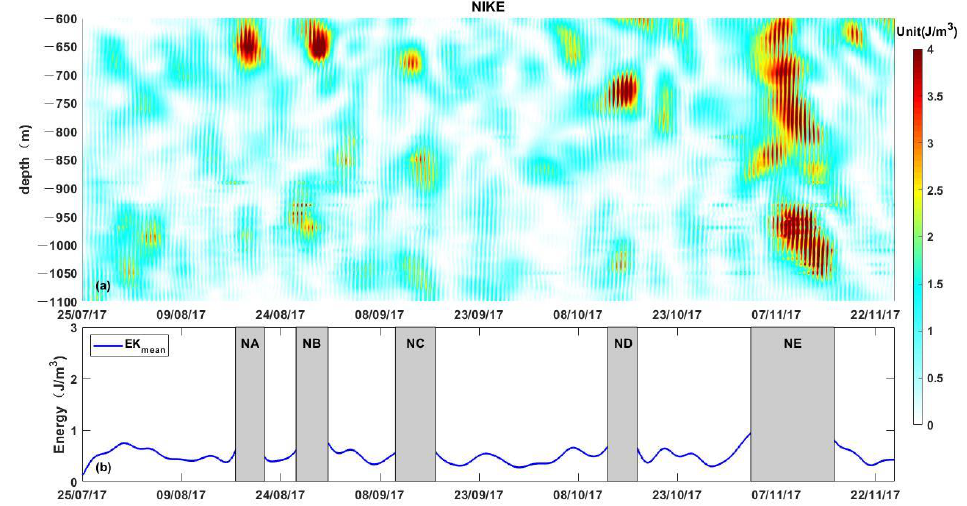
Figure 3. ( a ) Depth–time map of near-inertial kinetic energy (NIKE) per unit of volume, NIKE = 0.5 ρ ( u f 2 + v f 2 ) (J/m 3 ), and ( b ) depth-averaged components. The shaded area represents a significant near-inertial signal. The names of these five phenomena are marked in the shaded area.